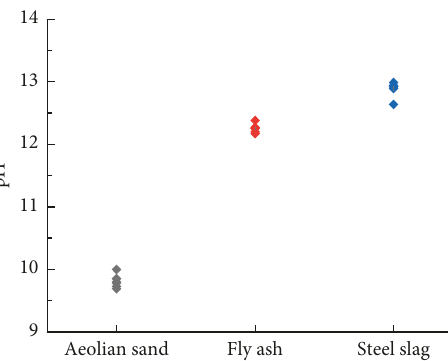
Figure 3: Three types of material pH